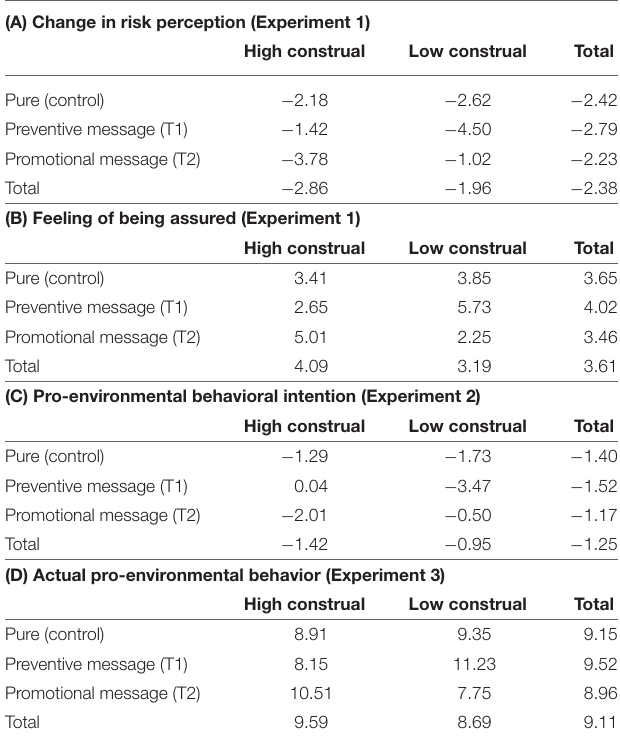
TABLE 1 | Within-group mean of dependent